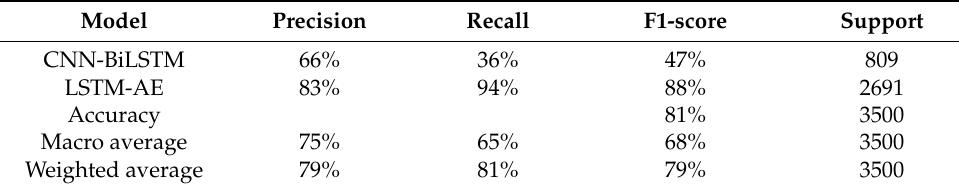
Table 10. Auto-selective model prediction engine classification report.